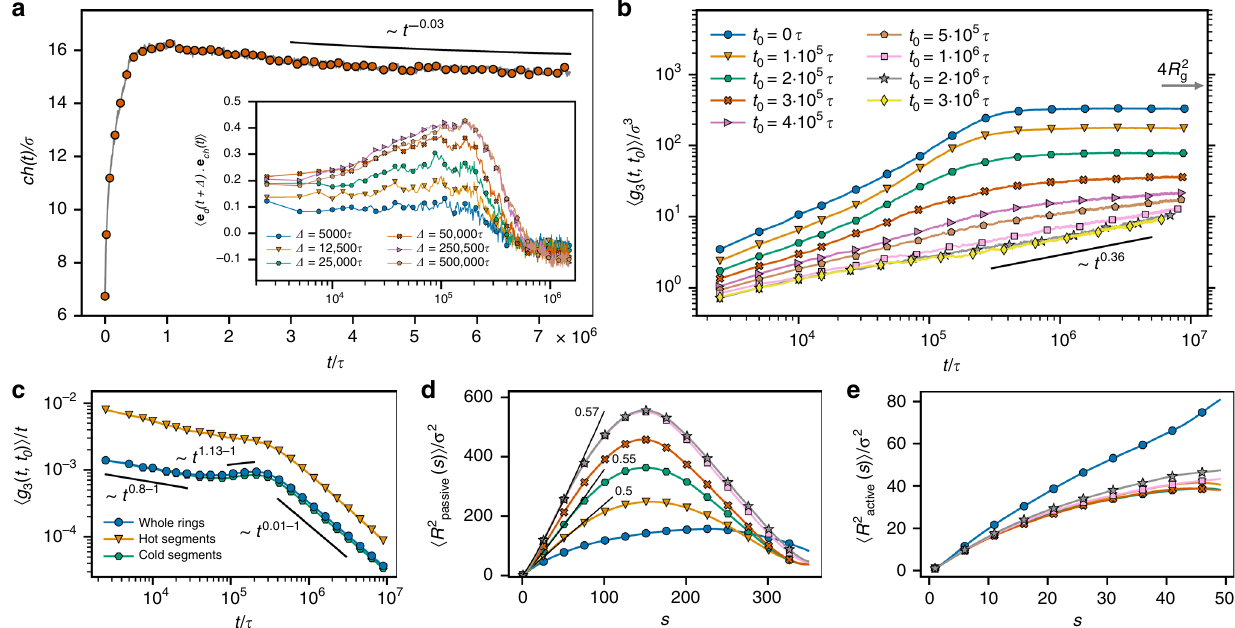
Fig. 2 Evolution of the dynamics. a Mean magnitude of the cold – hot vector ch as a function of time. Inset: correlation of the ch direction with the direction of the center of mass displacements of the rings in different lag times Δ as a function of time t after the activity onset ( e d ð t þ Δ Þ and e ch ð t Þ are unit vectors in the direction of d ð t Þ ¼ R ð t þ Δ Þ (cid:2) R ð t Þ and ch ð t Þ , respectively). b Mean squared displacement of the centers of mass of the rings, h g 3 ð t ; t 0 Þi , as a function of time t measured from different times t 0 after the activity onset. c h g 3 ð t ; t 0 Þi = t as a function of time for t 0 ¼ 0. d , e Time-resolved mean squared i , computed for each segment length s as the squared distance of the internal distance for the passive ( d ) and the active ( e ) segment h R 2 ð s Þ passive = active endpoints of the segment averaged over the segments position within the passive/active block of a ring and averaged over rings. The black straight lines in ( d ) emphasize the scaling behavior h R 2 ð s Þi (cid:3) s 2 ν trail for low s with the numbers indicating ν for a few characteristic times after the activity onset. Panels trail b , d , and e share the same legend shown in ( b